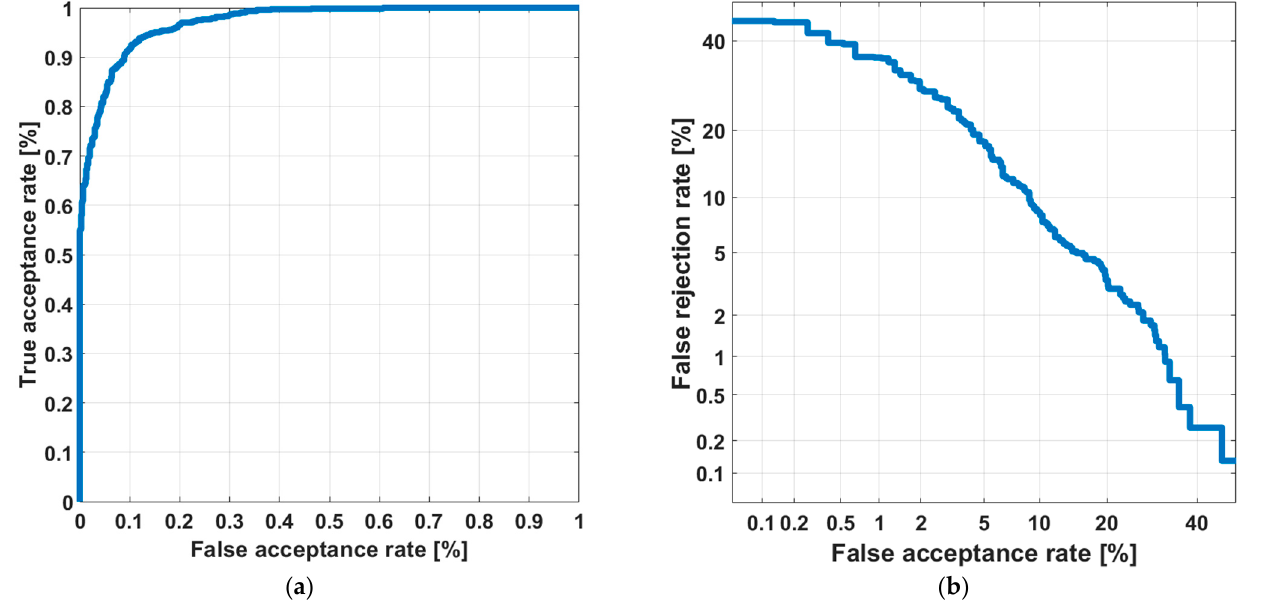
Figure 8. Results of speaker identification in an open set of voices, ( a ) ROC curve; ( b ) DET curve. Table 3. Comparison of the results, effectiveness of ASR Systems using the TIMIT